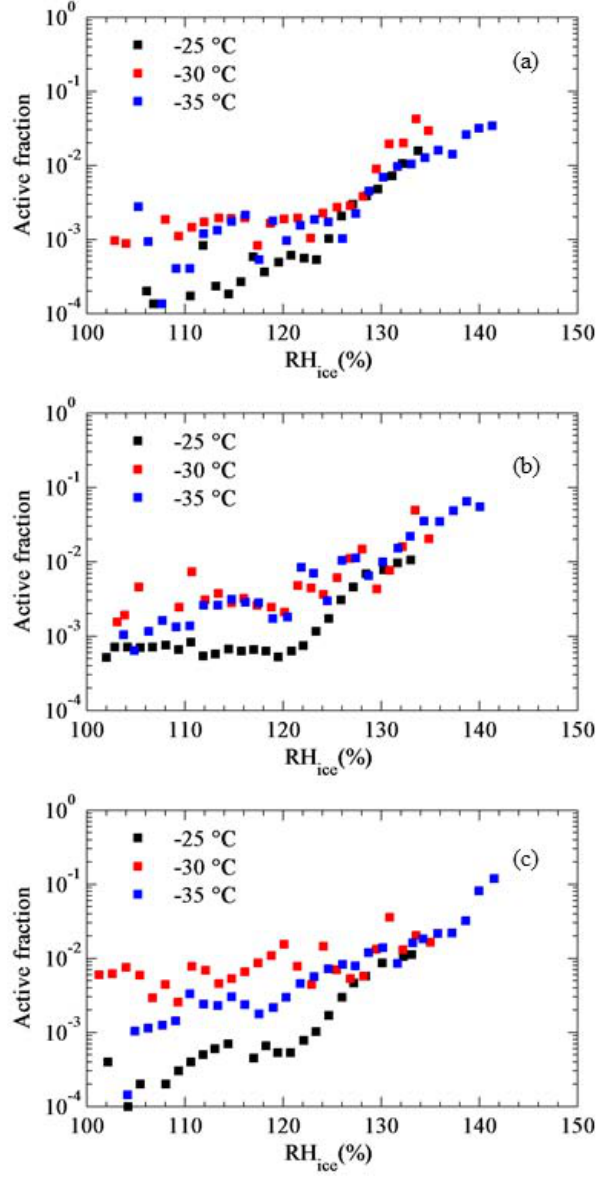
Fig. 4. Active fraction of ATD particles as a function of RH ice (%). Three different size particles were investigated at temperatures of − 25, − 30 and − 35 ◦ C. (a) , (b) and (c) corresponds to the 100 nm, 300nm and 500nm diameter particles,